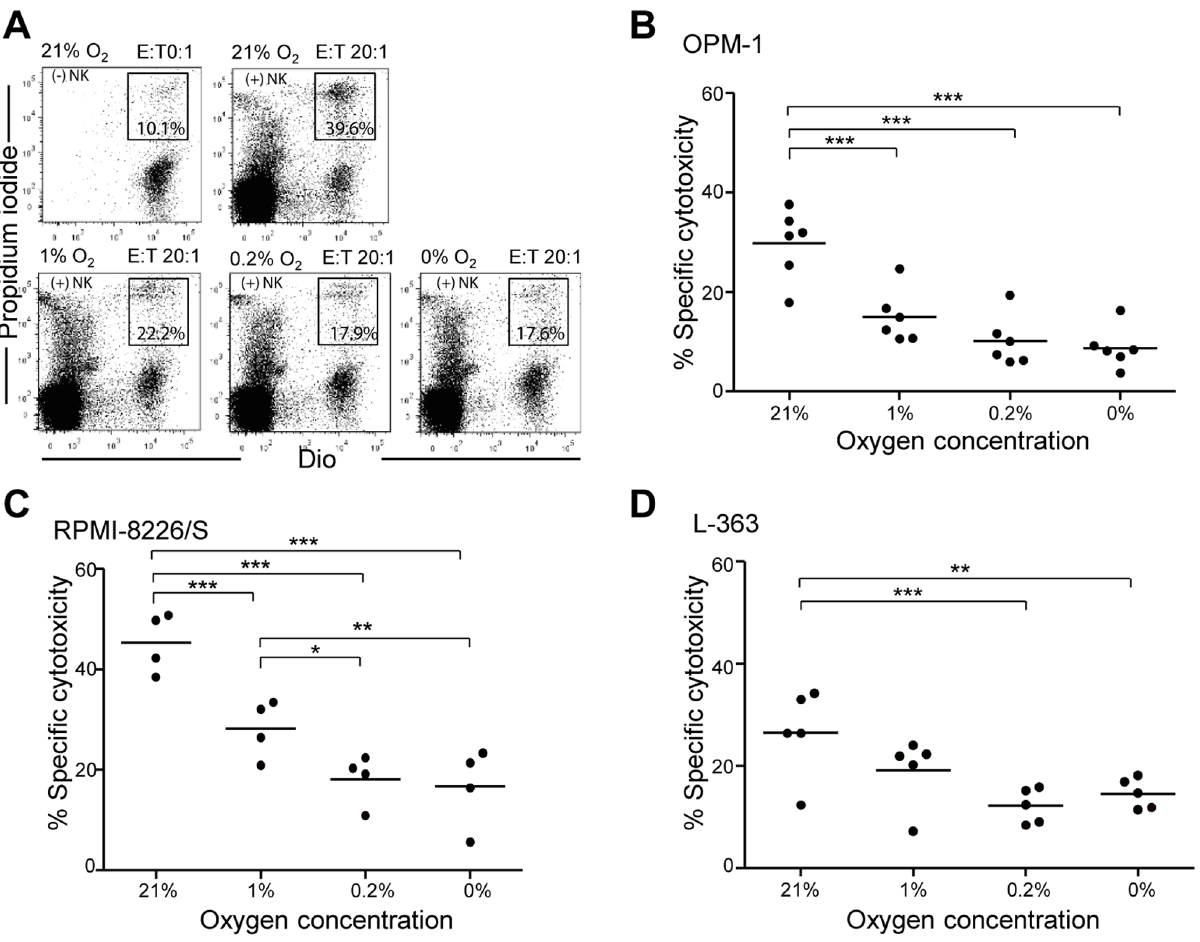
Figure 1. Hypoxia diminishes the cytotoxic potential of NK cells. Freshly isolated NK cells and DiO labeled myeloma cell lines (OPM-1, RPMI- 8226/S and L-363) were cultured at 21%, 1%, 0.2% or 0% O 2 , for 14–16 hours, followed by assessment of the cytotoxic potential of NK cells in a 4.5 hour assay at corresponding oxygen levels. (A) Representative dotplots of OPM-1 cells cultured with NK cells at 20:1 (E:T) ratio and (B–D) quantification of dotplots of 4–6 donors for different MM cell lines. Each dot represents mean of triplicate cultures of an individual donor. Statistics were performed with one-way repeated measures ANOVA with Bonferroni correction * p , 0.05, ** p , 0.01, *** p , 0.001.